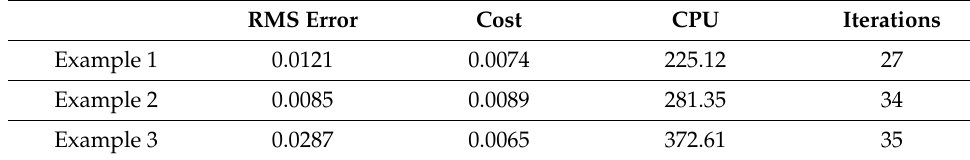
Table 3. Results with exact data.